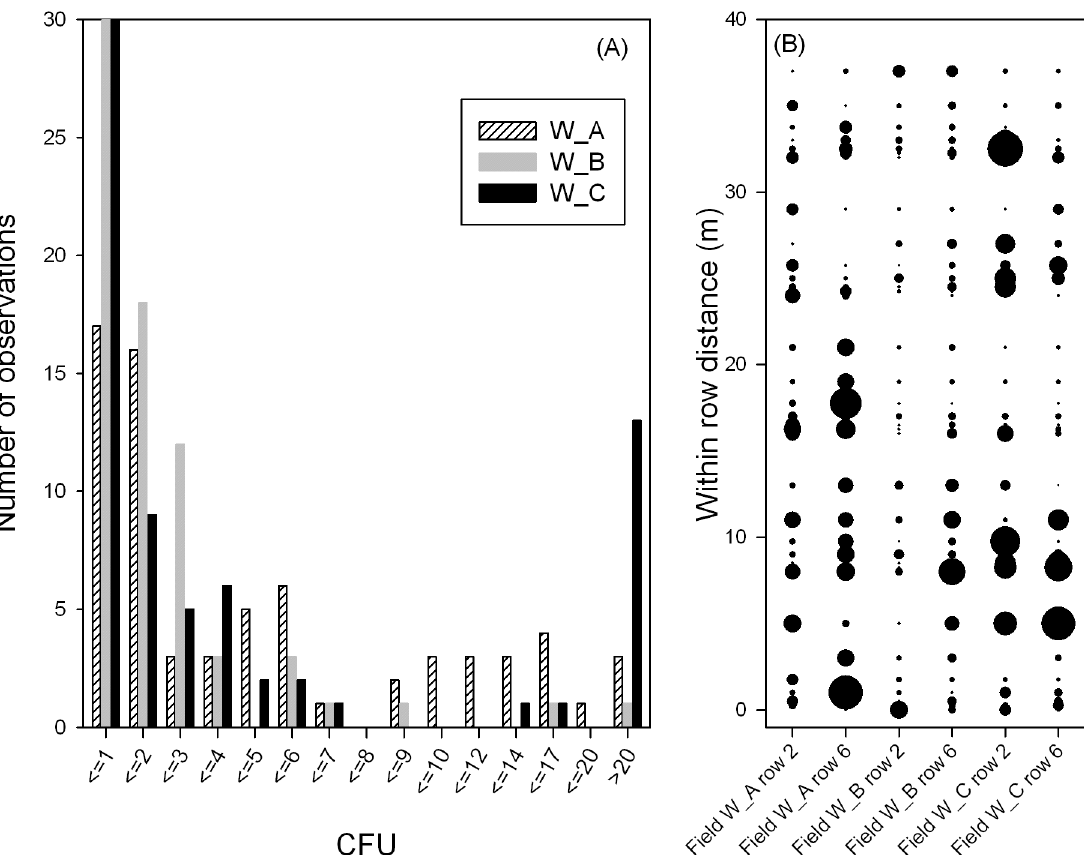
Fig 3. Inoculum density of Verticillium dahliae from point sampling. Histogram (A) and spatial pattern (B) of estimated inoculum density (CFU g -1 of soil) of Verticillium dahliae in three commercial cotton fields (W_A, W_B, and W_C) using a real-time quantitative PCR method. Within each row, 35 soil samples (at depth 0 – 20cm) were taken; the circle size is proportional to the CFU estimate at the point (the largest circle corresponds to 300 CFU g -1 of soil in